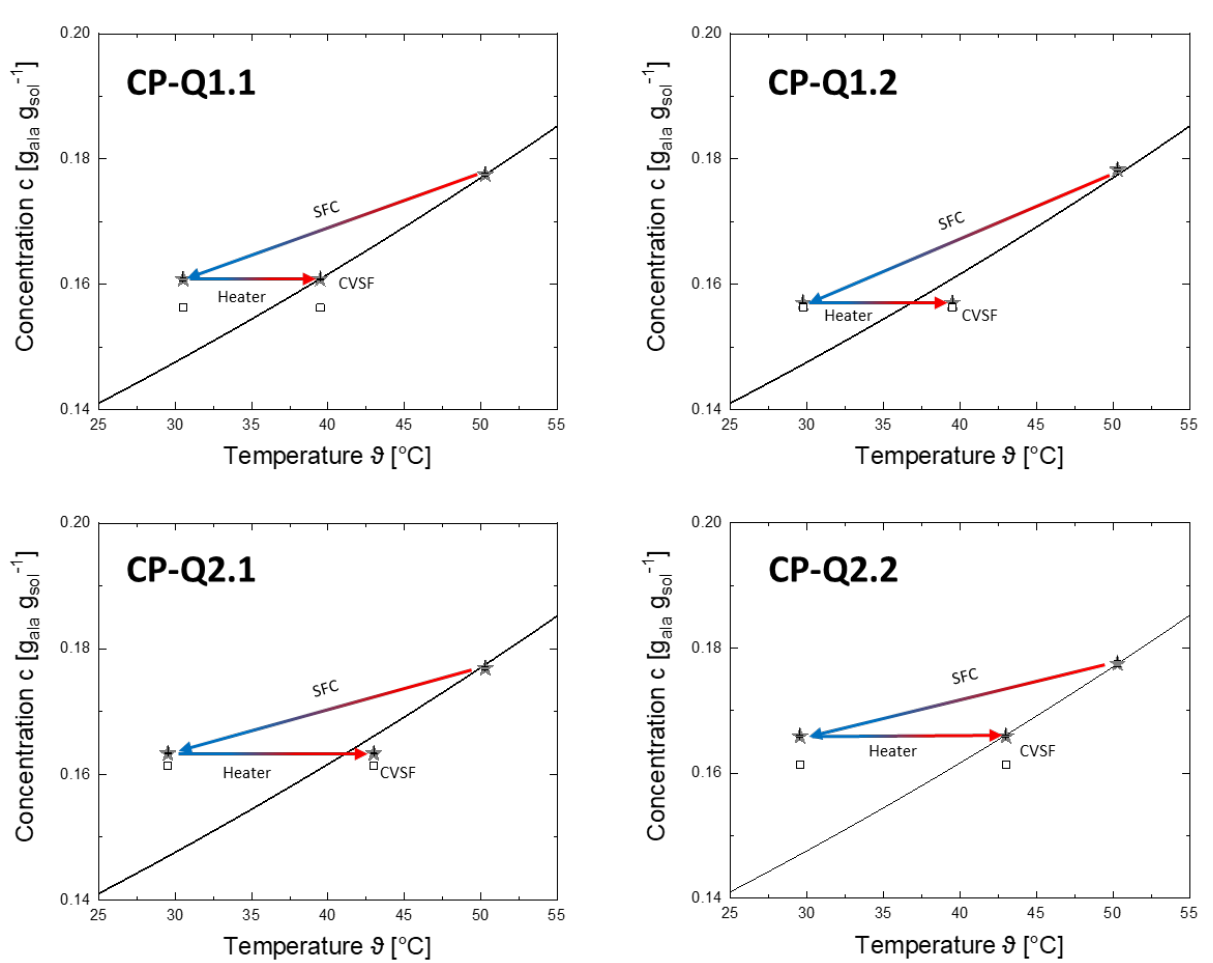
Figure 5. c , T diagrams of the experiments conducted for Q susp = 10 mL min − 1 ( upper half , CP-Q1) and Q susp = 20 mL min − 1 ( lower half , CP-Q2). The operating parameters are shown in Table 1. The grey stars show the concentrations measured in the experiments whereas the squares represent the estimated concentrations.